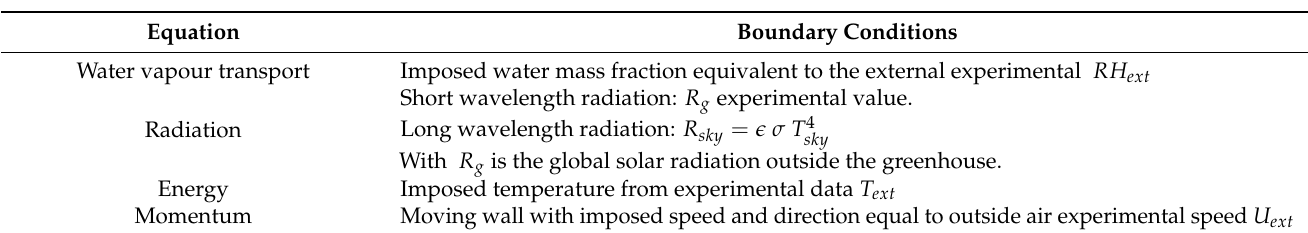
Table A4. Domain top